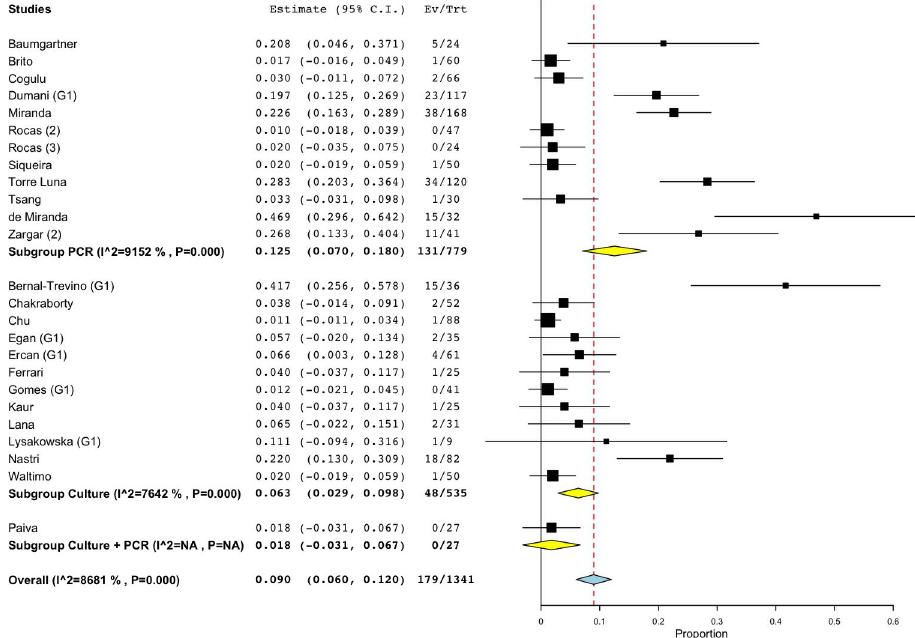
Fig 3. Forest plot representing fungal species prevalence in primary endodontic infections, distinguishing the methods of detection.